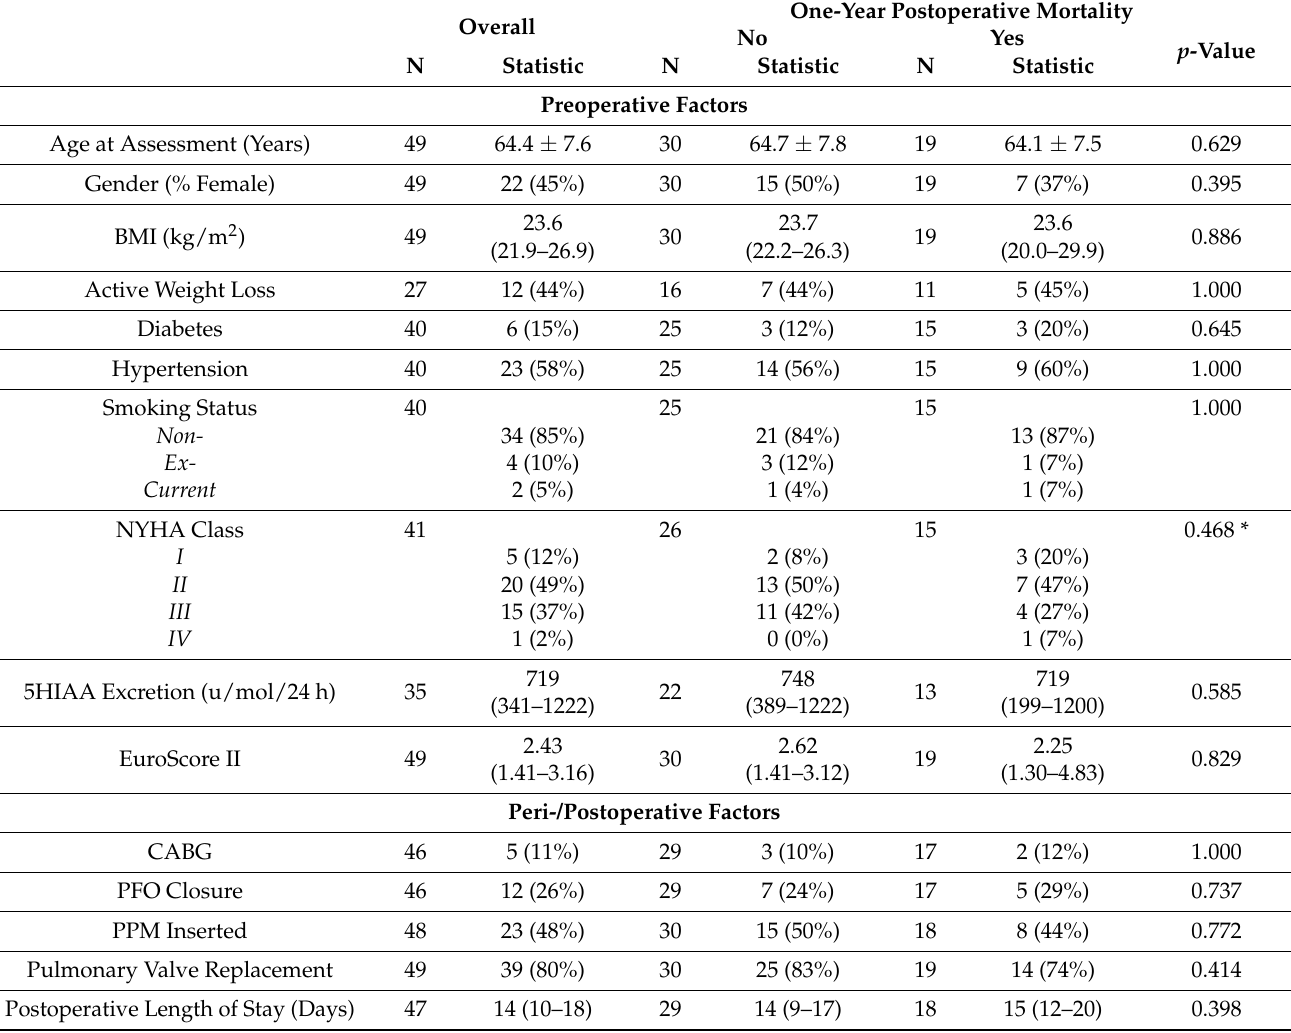
Table 1. Cohort Characteristics and Associations with One-Year